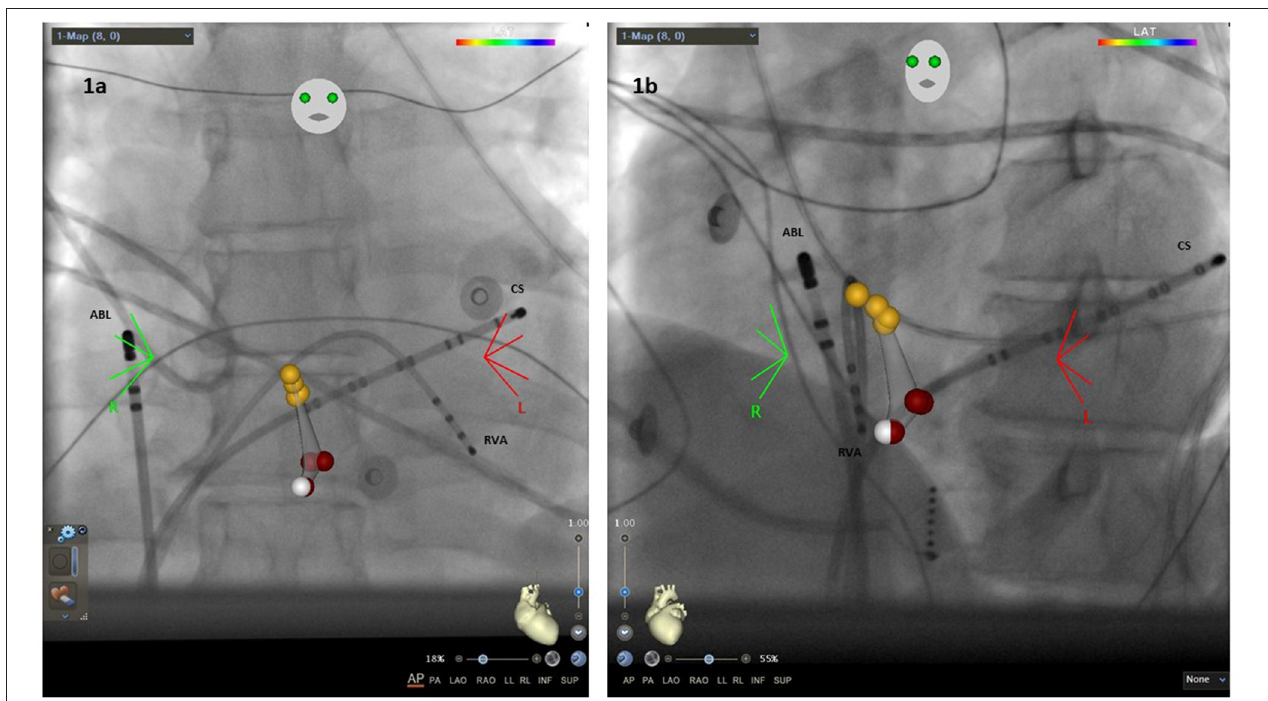
FIGURE 1 | (a) Anterior-posterior (AP) view with the ablation catheter (ABL) placed in the right atrium, one catheter in the coronary sinus (CS) and one in the right ventricular apex (RVA). Yellow dots, region of HIS bundle; white dots, slow pathway region; red dots, ablation points. (b) Left anterior oblique (LAO) 40 ◦ view.